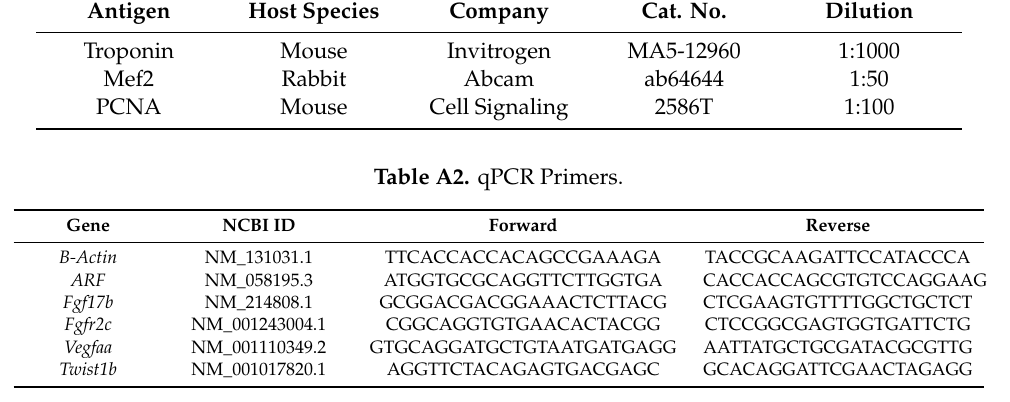
Figure S1: Arf deficiency is insu ffi cient for murine digit regeneration.